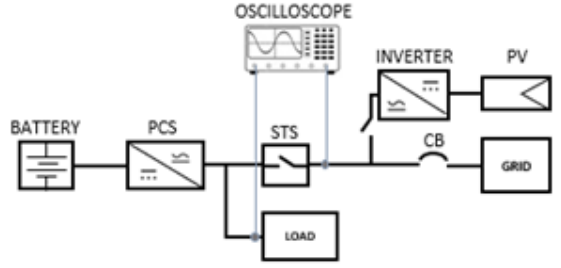
Figure 5. Test Configuration.